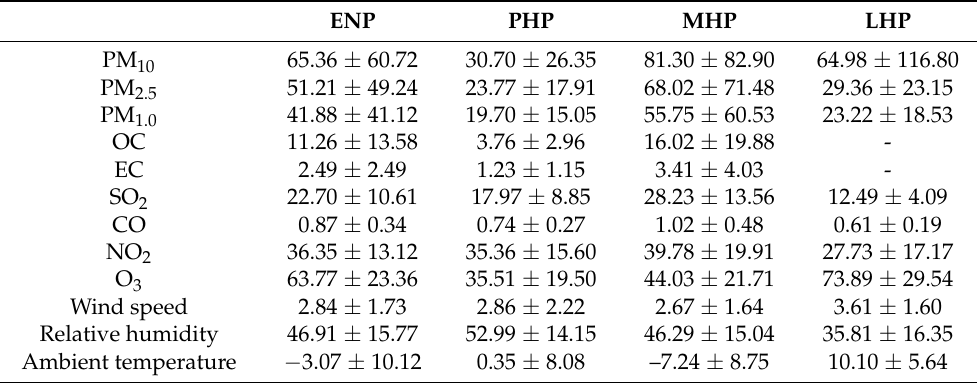
Table 1. Daily average concentrations of pollutants (i.e., PM 10 , PM 2.5 , PM 1.0 , OC, EC, SO 2 , CO, NO 2 and O 3 ) and meteorological elements (i.e., temperature, relative humidity, wind speed and direction) during PHP, MHP and LHP in Harbin. Except for CO, the unit of remaining pollutants is µ g/m 3 , while CO is mg/m 3 ; the units of wind speed, relative humidity and ambient temperature are m/s, % and ◦ C, respectively. ENP PHP MHP LHP PM